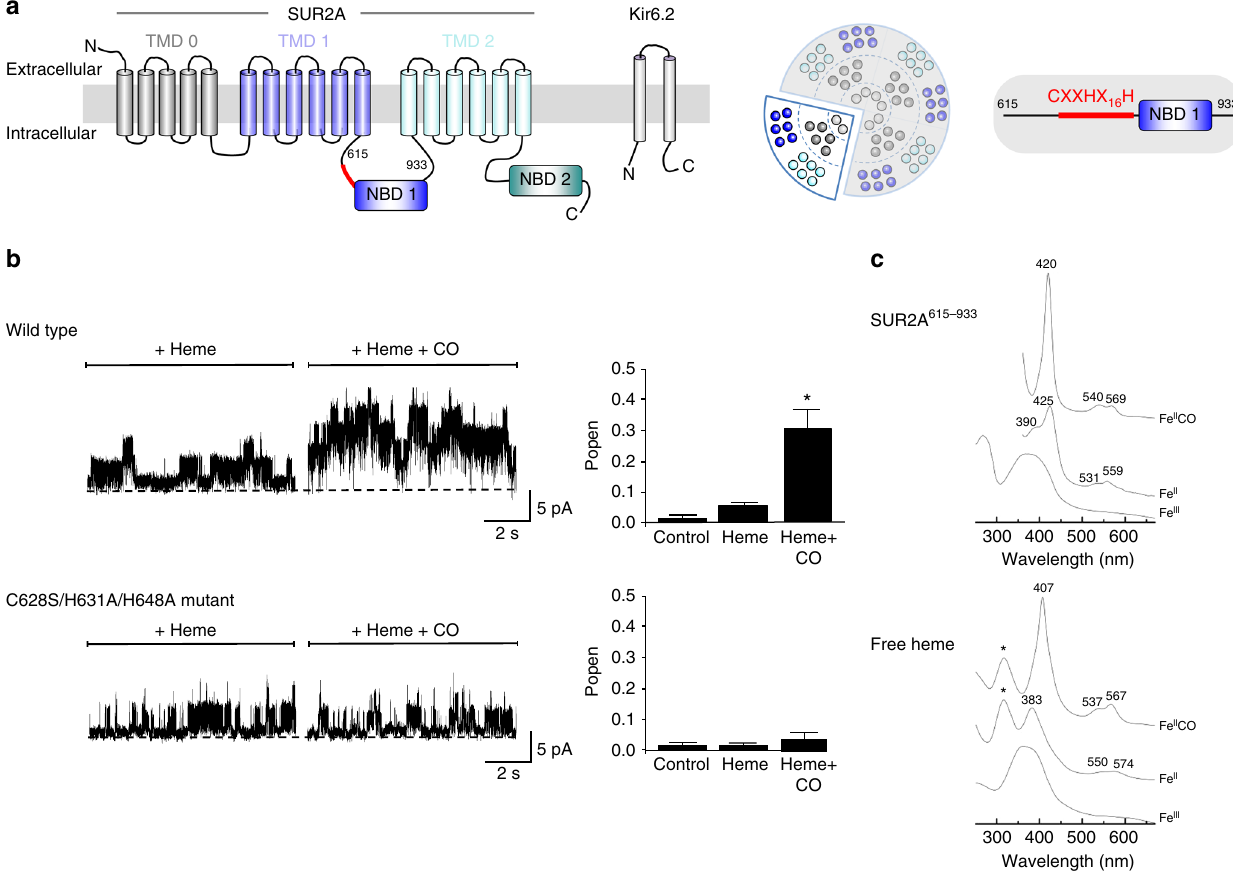
Fig. 1 Heme is required for CO-dependent increase in channel activity. a Schematic of the K ATP channel subunit and protein structure. There are four sulphonylurea receptor (SUR) subunits which are members of the ATP-binding cassette (ABC) transporter subfamily c (SUR2A in this work), and a further four pore-lining subunits of the inward recti fi er family (Kir6.2, shown on left). These assemble to form an octameric channel structure (shown in the middle). Red indicates the region of the SUR2A subunit containing the CXXHX 16 H heme binding motif adjoining the nucleotide-binding domain (NBD1). On the far right is shown schematically the S615-L933 region of rat SUR2A containing NDB1 and the CXXHX 16 H heme binding motif. b Mutation of residues in the heme binding region or SUR2A abolishes the heme-dependent CO increase in K ATP channel open probability. (Top) Inside – out single channel analysis of the effects of heme and heme/CO on wild type K ATP channel activity and a summary showing the mean open probability changes in response to heme and CO ( n = 6). (Bottom) Effects of mutation of the heme binding site, in the triple C628S/H631A/H648A mutant of SUR2A, on the responses of single channel currents and mean open probability to heme and CO ( n = 6, * P < 0.05, paired T test). c Absorption spectra of SUR2A 615 – 933 (top three spectra) and free heme (bottom three spectra) in the ferric (Fe III ), ferrous (Fe II ) and ferrous CO-bound (Fe II -CO) forms. The ferric form of free heme is characterized by a broad Soret band centered at 377 nm 53 , which probably arises from different heme conformations; reduction of free heme with dithionite leads to a red-shifted Soret band at 383 nm which is attributed to a 5-coordinate high spin species and closely resembles that of dithionite- reduced hemin in 0.5% sodium dodecyl sulphate 54 ( λ max = 395, 405, 425 (weak), 439 (weak) nm). Addition of CO to reduced heme results in the formation of a complex with a Soret band at 407 nm and Q-bands at 537 and 657 nm